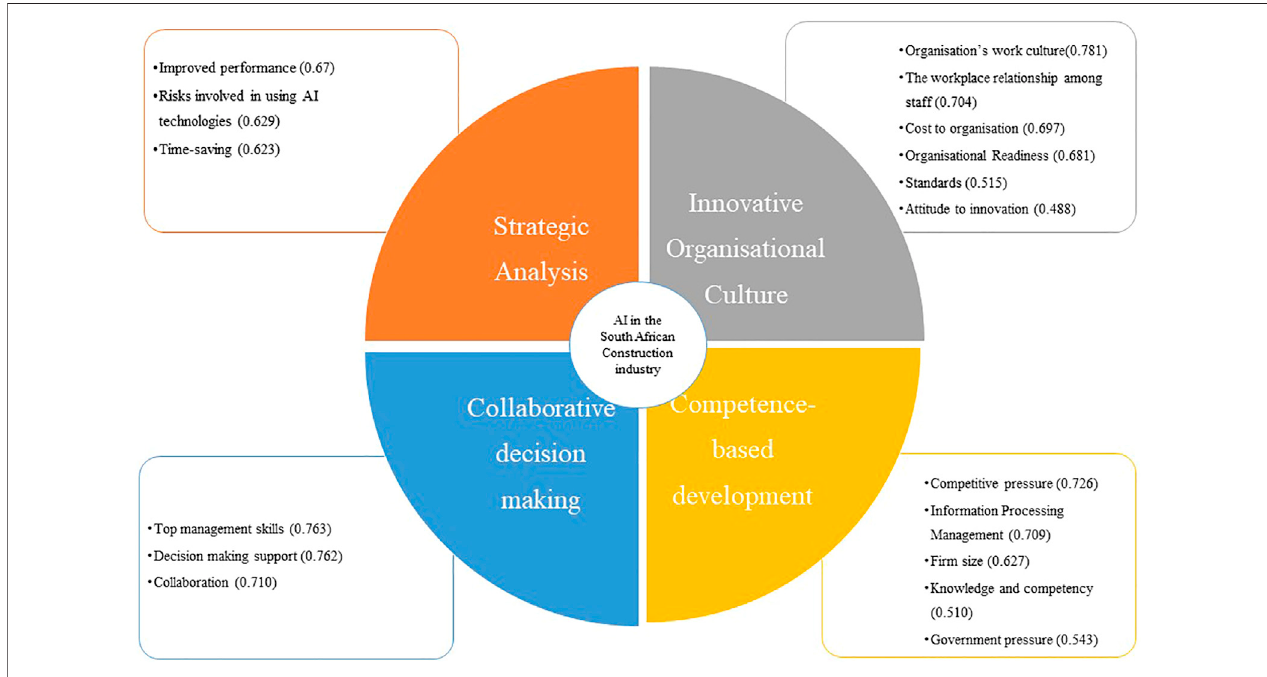
FIGURE 2 | Diagrammatic representation of the organisational